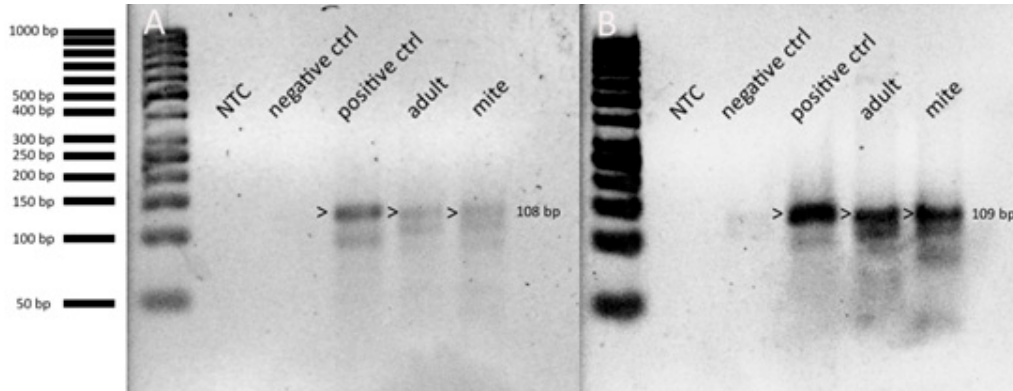
Figure 7. Inverted image of the high-resolution analysis of Reverse Transcriptase Multiplex Ligation Probe Amplification (RT-MLPA) to detect the negative strand intermediate of LJV in ( A ) and KiV in ( B ) in samples of adult bees and varroa mites. RT-MLPA analysis was performed using 4% high-resolution gel electrophoresis with a GeneRuler 50 bp ladder (Thermo Scientific). For each virus, the synthetic negative strand was used as positive control. We included also a non-infected honey bee adult as a negative control and a no-template control (NTC). Bands marked with an arrowhead confirm the presence of negative strand intermediate.